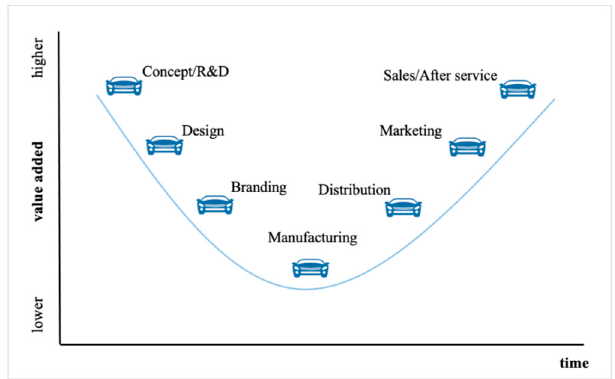
Figure 4. GVC in terms of added value (individual processes). Source: Authors’ compilation.